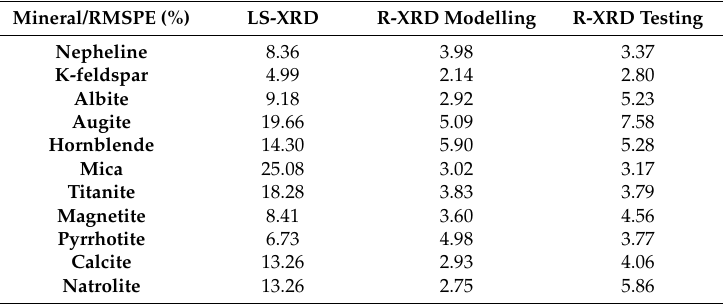
Table 9. Average magnetic separation feed, concentrate, and tailing data RMSPE between measured and estimated XRD. The estimation used average normalized mineral chemistry from Table 6.